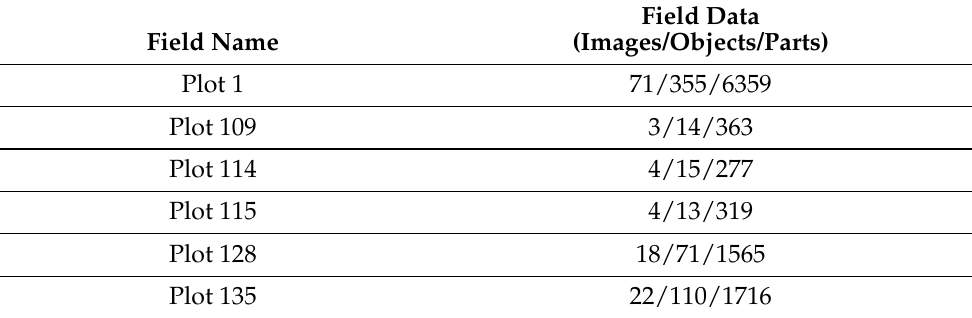
Table 2. Wheat fields data for robust estimation.